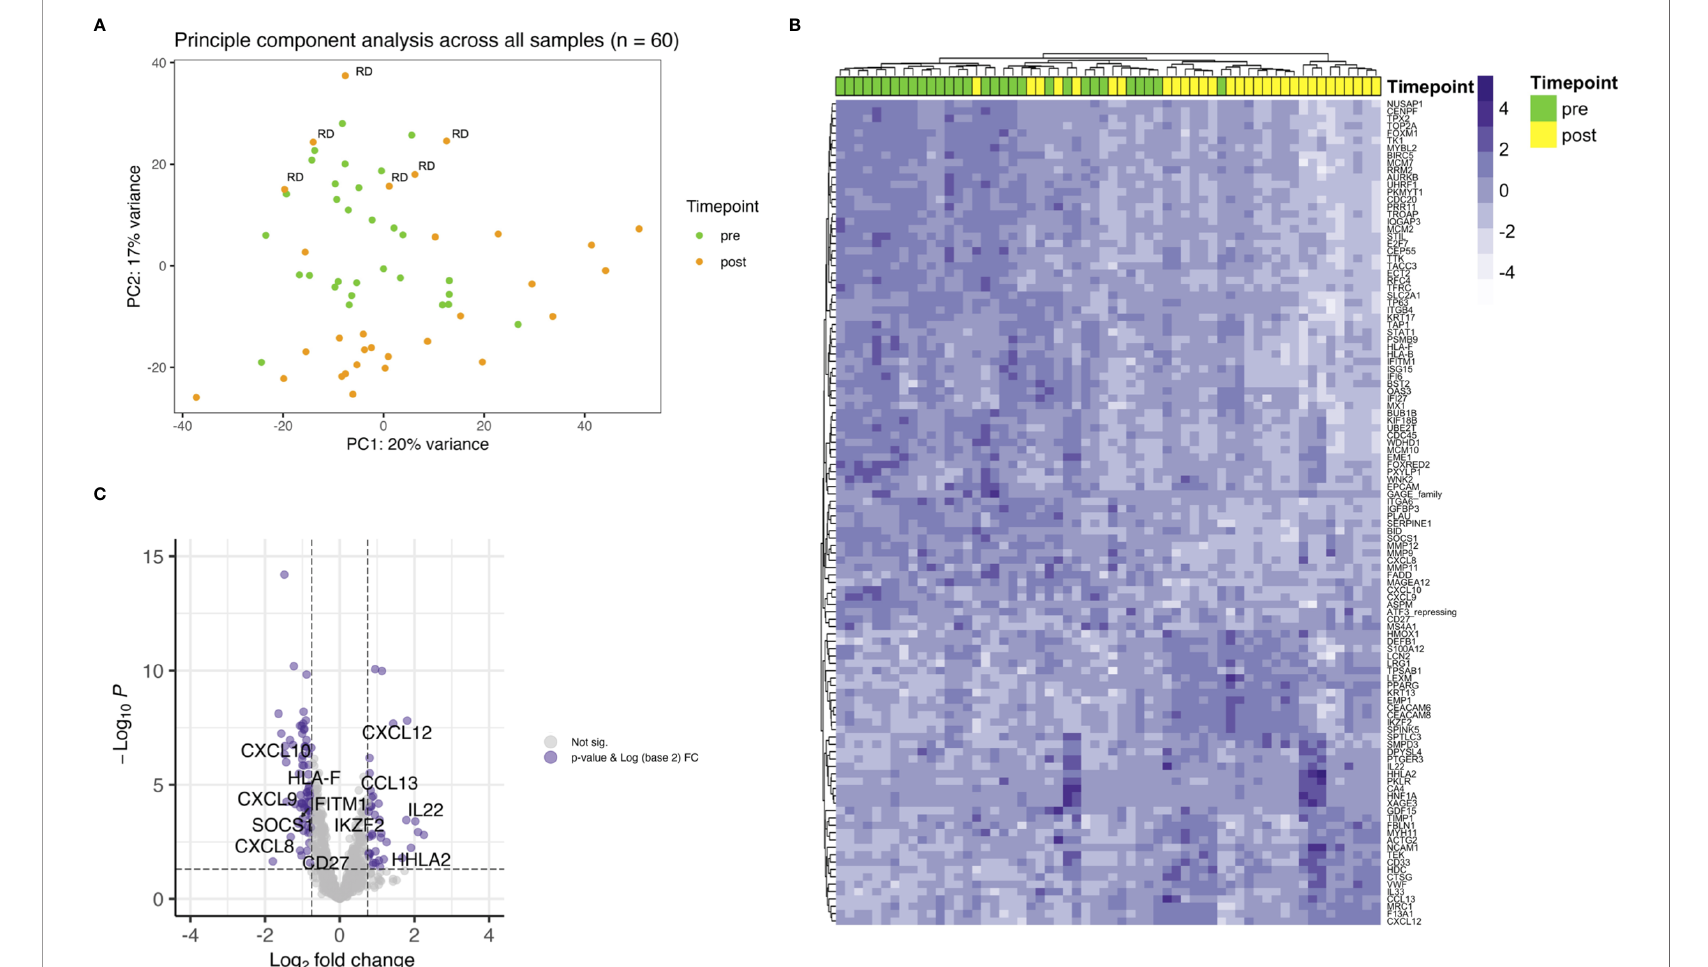
FIGURE 1 | Showing differential gene expression for the whole cohort. (A) PCA plot indicating clustering of pretreatment samples (green) and posttreatment samples (orange). Within the green cluster posttreatment samples with RD are present. (B) Heatmap depicting unsupervised hierarchical clustering using Euclidian distance for genes with expressed with an FDR < 0.05 and a log2 FC over 0.75. (C) Up- and downregulation of T cell related genes after